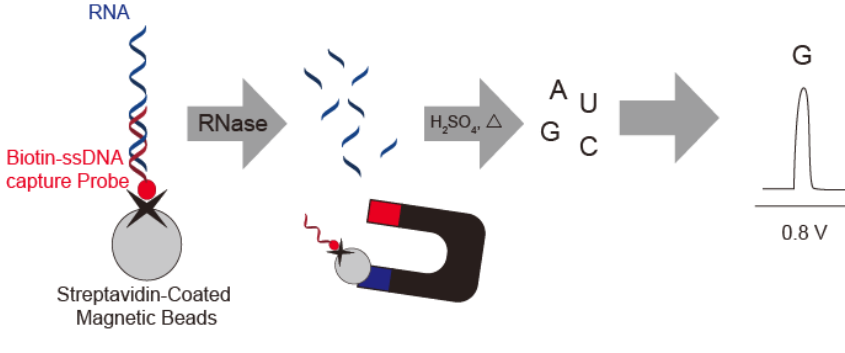
Figure 9. RNase digestion and dipurinization is followed by stripping chronopotentiometric measurements with a graphite pencil electrode to produce a guanine redox peak.